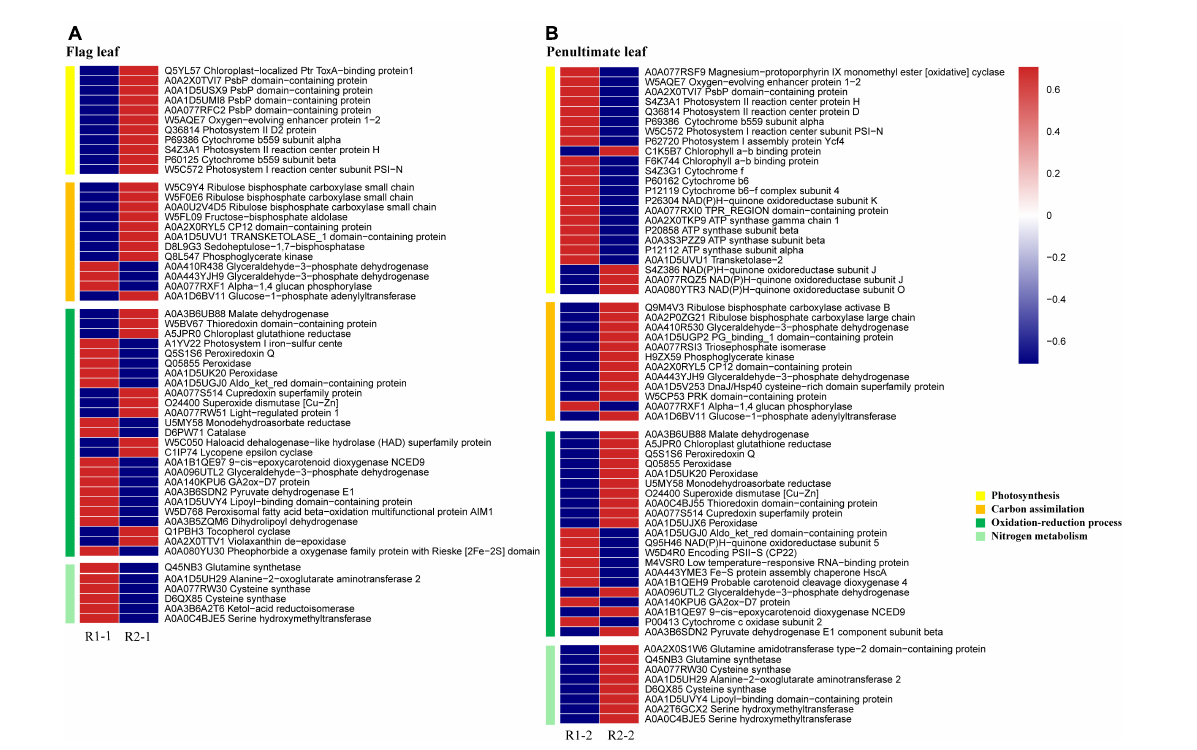
FIGURE7 Heatmaps of differentially expressed proteins (DEPs) related to photosynthesis, carbon assimilation, oxidation-reduction process, and nitrogen metabolism in the flag (A) and penultimate leaves (B) under different row spacing treatments. Relative abundance presented by a color scale from red (high) to blue